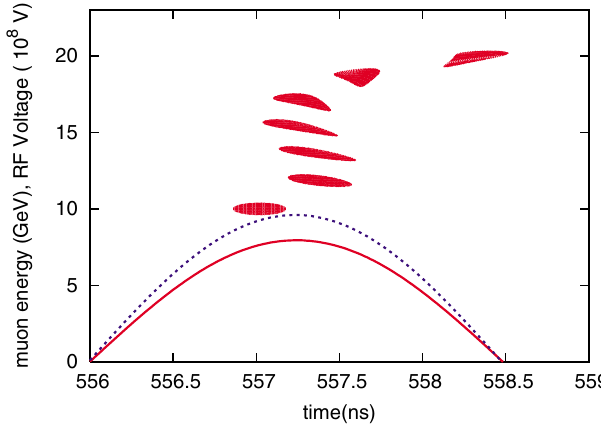
FIG. 21. (Color) Initial (dash) and final (full) rf voltage, and evolution of the bunch on turns 0 ; 2 ; . . . 12 , for L (cid:1) 328 m . C 0